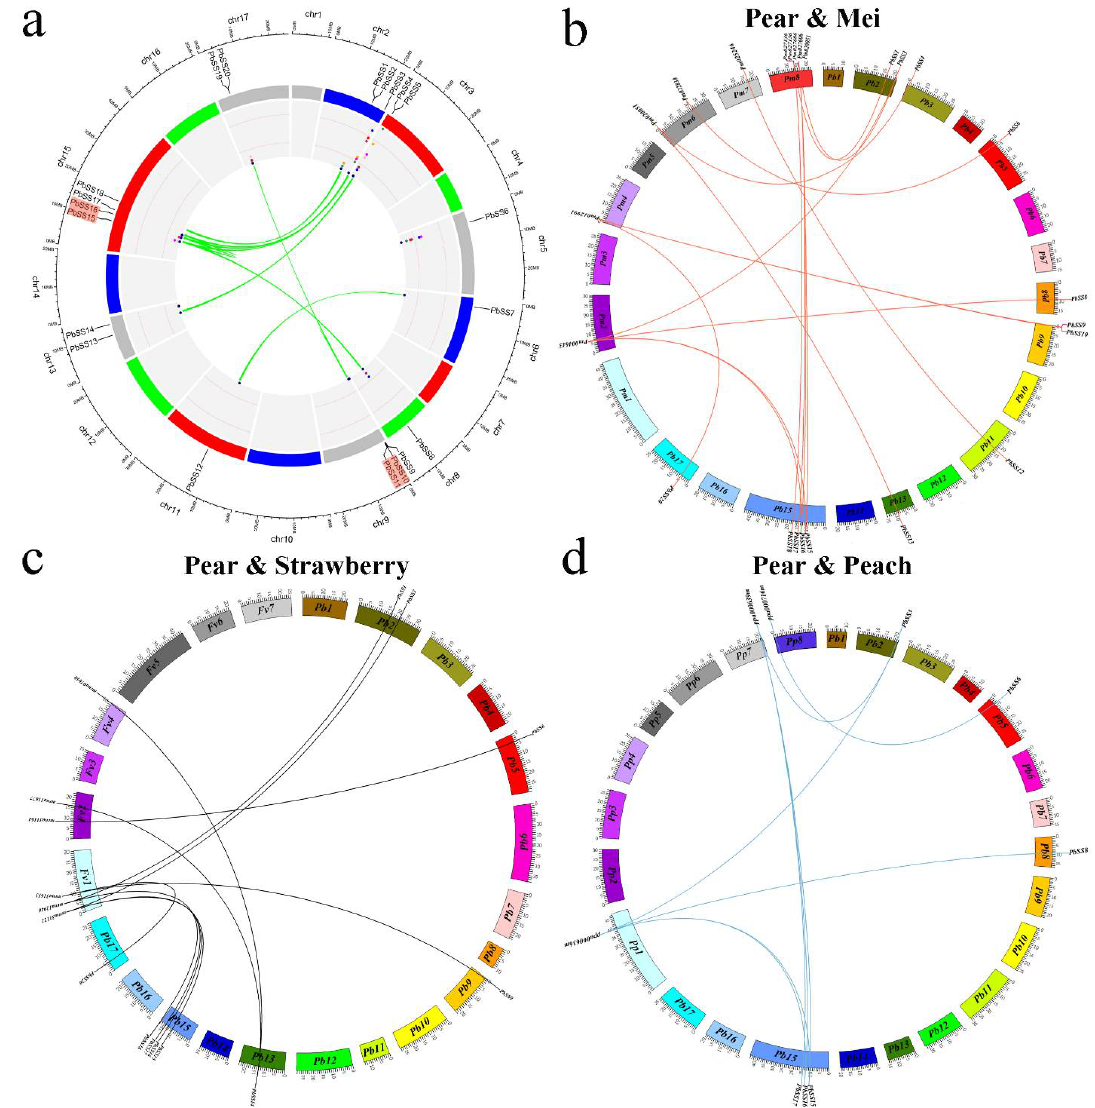
Figure 3. Chromosomal location and microsynteny regions of PbSSs genes. ( a ) Chromosomal location of all PbSSs genes and blue line represent segmental duplication and red highlighted PbSSs genes IDs represent tandem duplication. ( b ) Synteny analyses of PbSSs genes between Pyrus bretschneideri and Prunus mume . ( c ) Synteny analyses of PbSSs genes between Pyrus bretschneideri and Fragaria vesca. ( d ) Synteny analyses of PbSSs genes between Pyrus bretschneideri and Prunus persica .